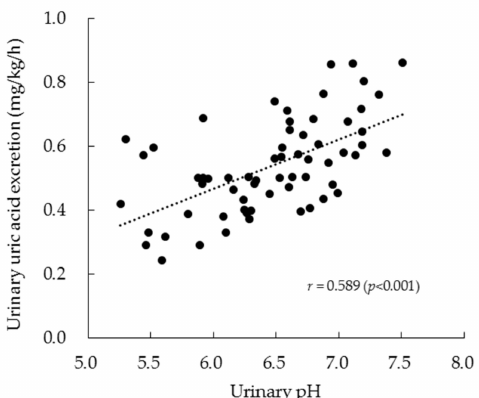
Figure 3. Relationship between urinary pH and urinary uric acid excretion in the crossover trial. The results represent the values ( n = 64) from all data points of all four experiments and the correlation coe ffi cient ( r ). Table 6. Relationship of urinary uric acid excretion or pH with serum amino acids levels. Serum Glycine Levels Serum Tryptophan